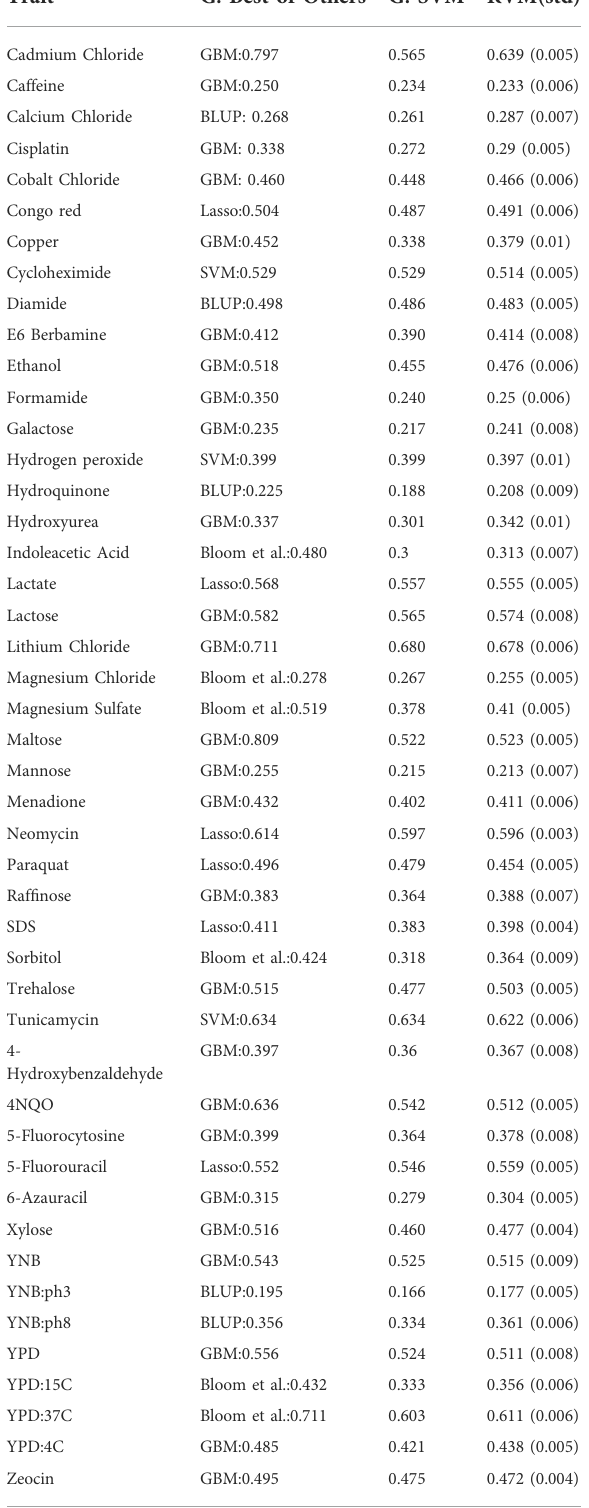
TABLE 3 RVM results versus Grinberg etal. ‘ s (G)(Grinbergetal.,2018). RVM represents the best performing RvM model and its standard